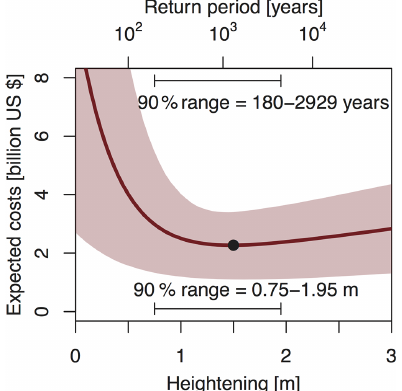
Figure 5. Illustrative cost–benefit analysis for the economically ef- ficient dike heightening (lower horizontal axis) and return period (upper horizontal axis) for the northern–central dike ring in New Orleans, Louisiana. The bold dot denotes the economically efficient (i.e., cost-minimizing) solution. The shaded region gives the 90% ensemble range of trade-off curves, and the bold line denotes the ensemble mean trade-off